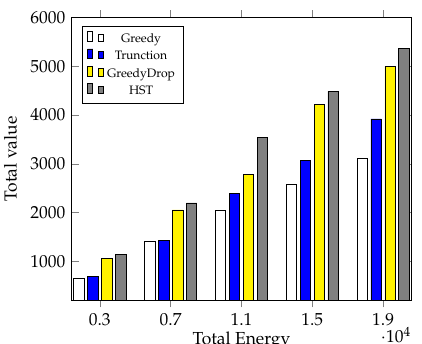
Figure 6. The effect of different amount of energy budget for FIFO tasks.